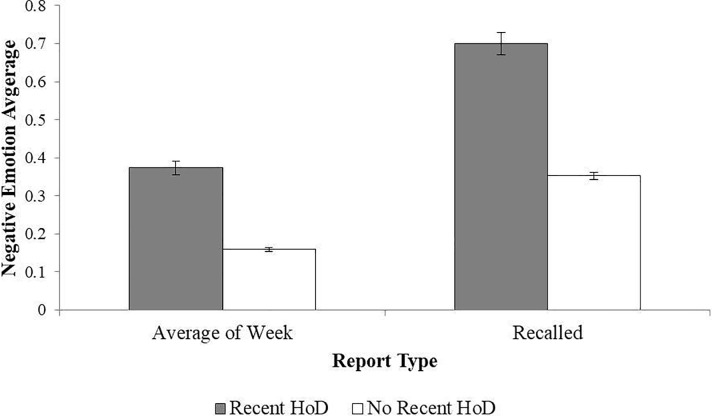
Negative emotion by recent history of depression.Note. Error bars represent standard error values. HoD = History of Depression. The model is adjusted for gender and evaluated at the following values: Age = 56.67, Education = 7.39.